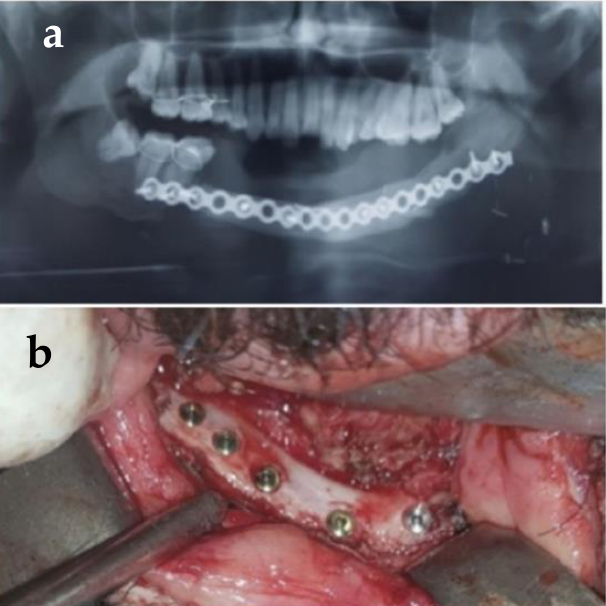
Figure 5. ( a ) OPG of patient showing reconstruction of Class III defect. ( b ) Class IV defect reconstruction in a patient with central giant-cell granuloma; transplanted fibula bone placed at the alveolar level.